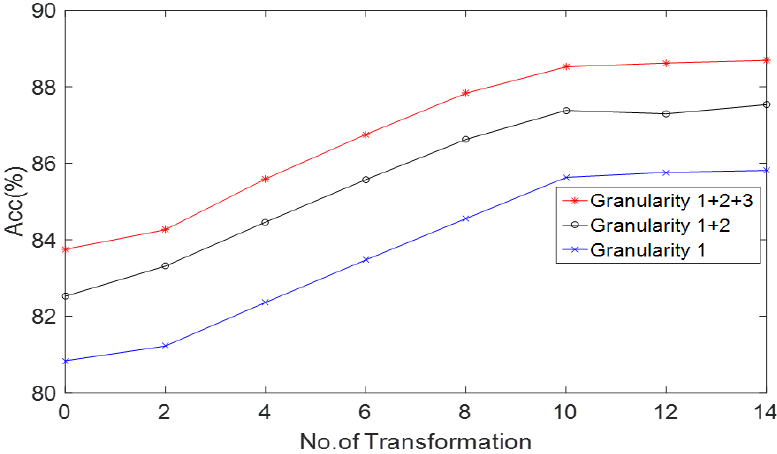
Figure 14. Accuracy gained by different granularities with different